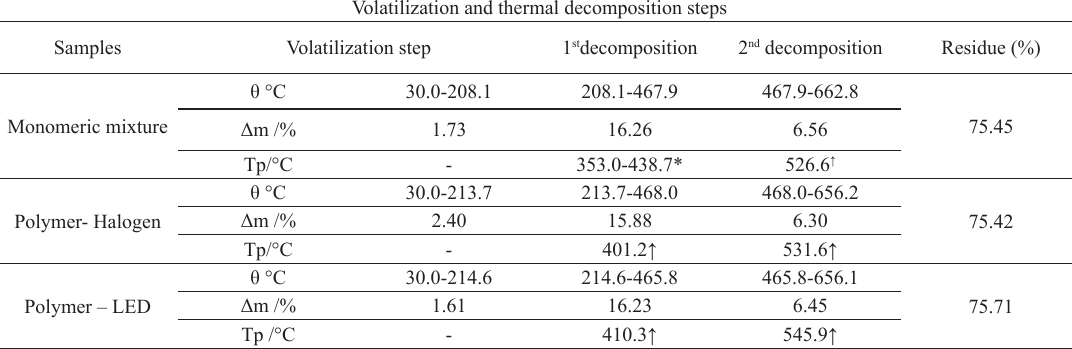
Table 2. Temperature of thermal events (θ°C), loss of mass (Δm) and peak temperature (T system samples.